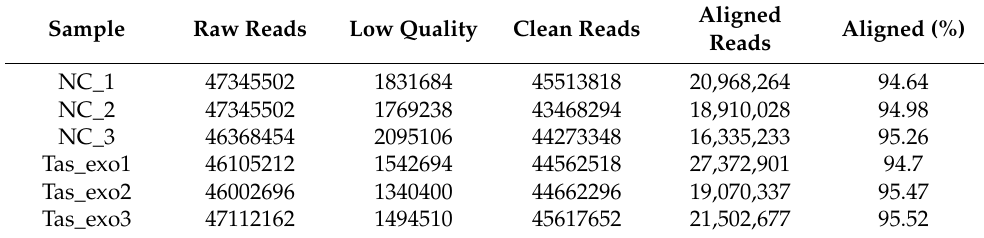
Table 1. Statistics of mRNA sequences of the mRNA